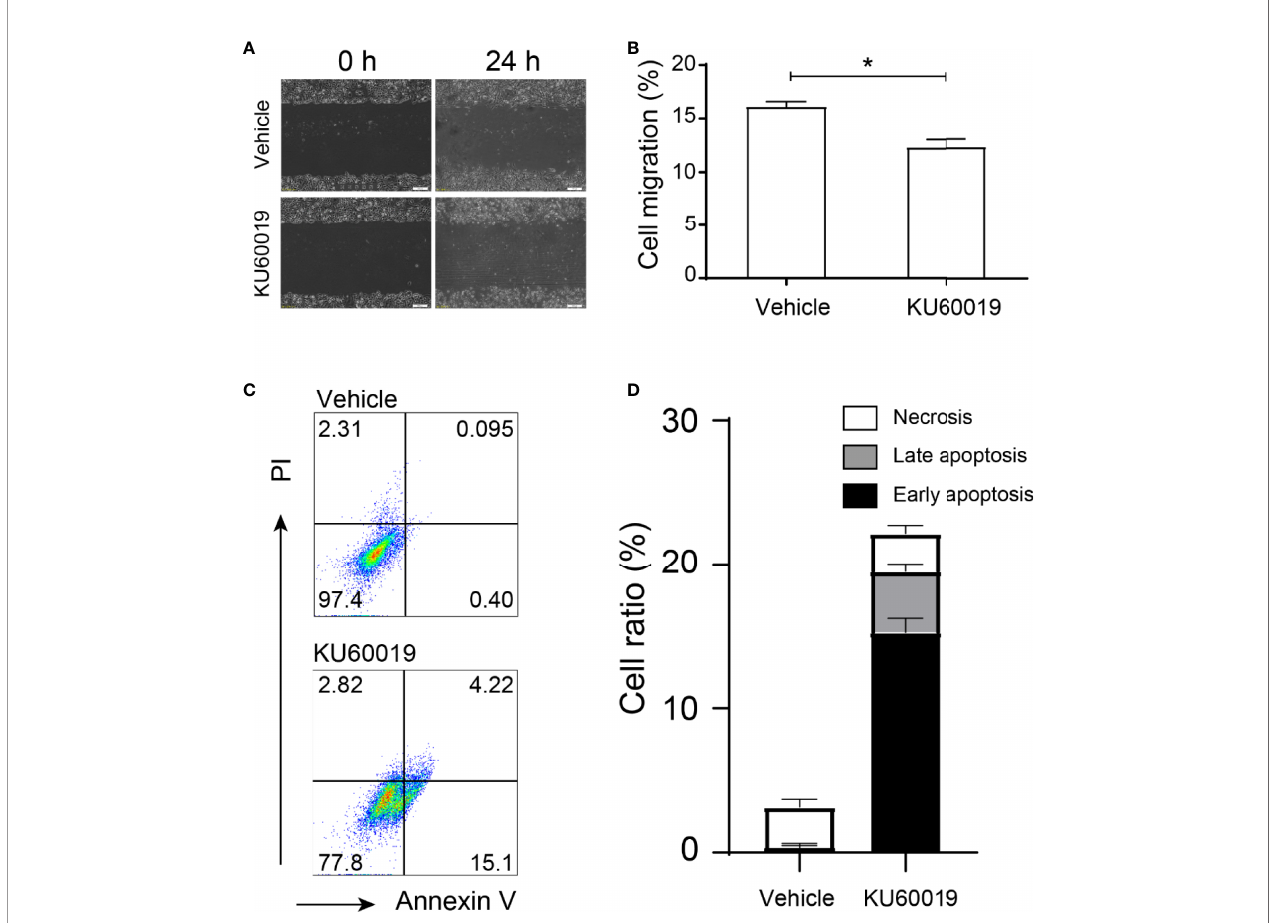
FIGURE 1 | ATM blocking inhibited performances in SKOV3 cells. SKOV3 cells were treated with vehicle or 10 m M KU60019 for 24h prior to wounding or apoptosis detection. Images were taken of each well at indicating time-points. The width of the wound was measured three times per image (A, B) . Cell apoptosis was detected by fl ow cytometry (C-D) . *P < 0.05. Data are representative of three independent experiments with similar results. Quanti fi cation of signal was shown in bar graphs and error bars represent mean ±